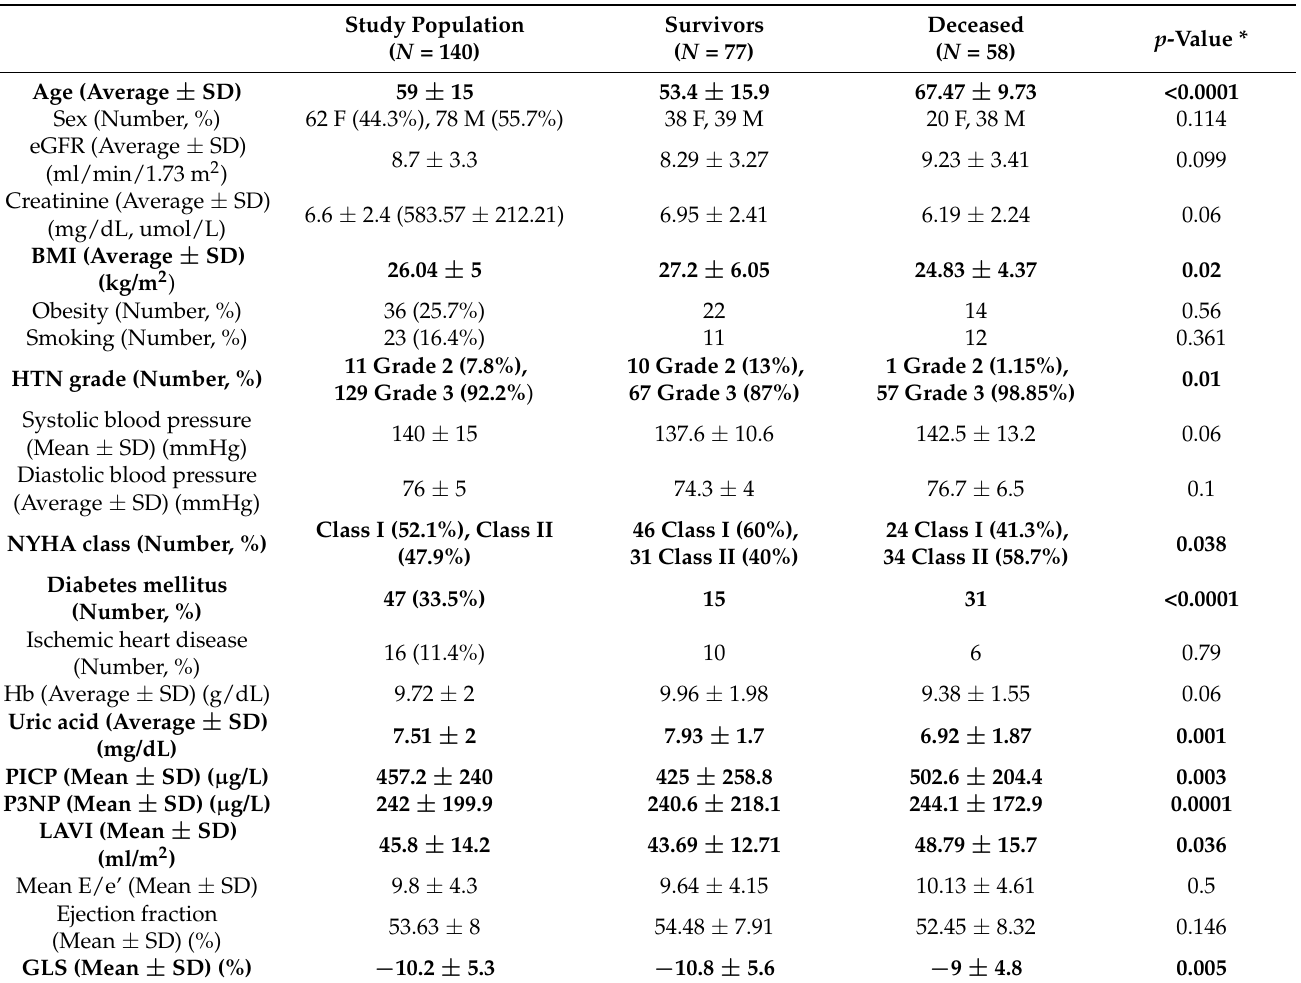
Table 1. Baseline characteristics and comparison between the patients who survived and died at three